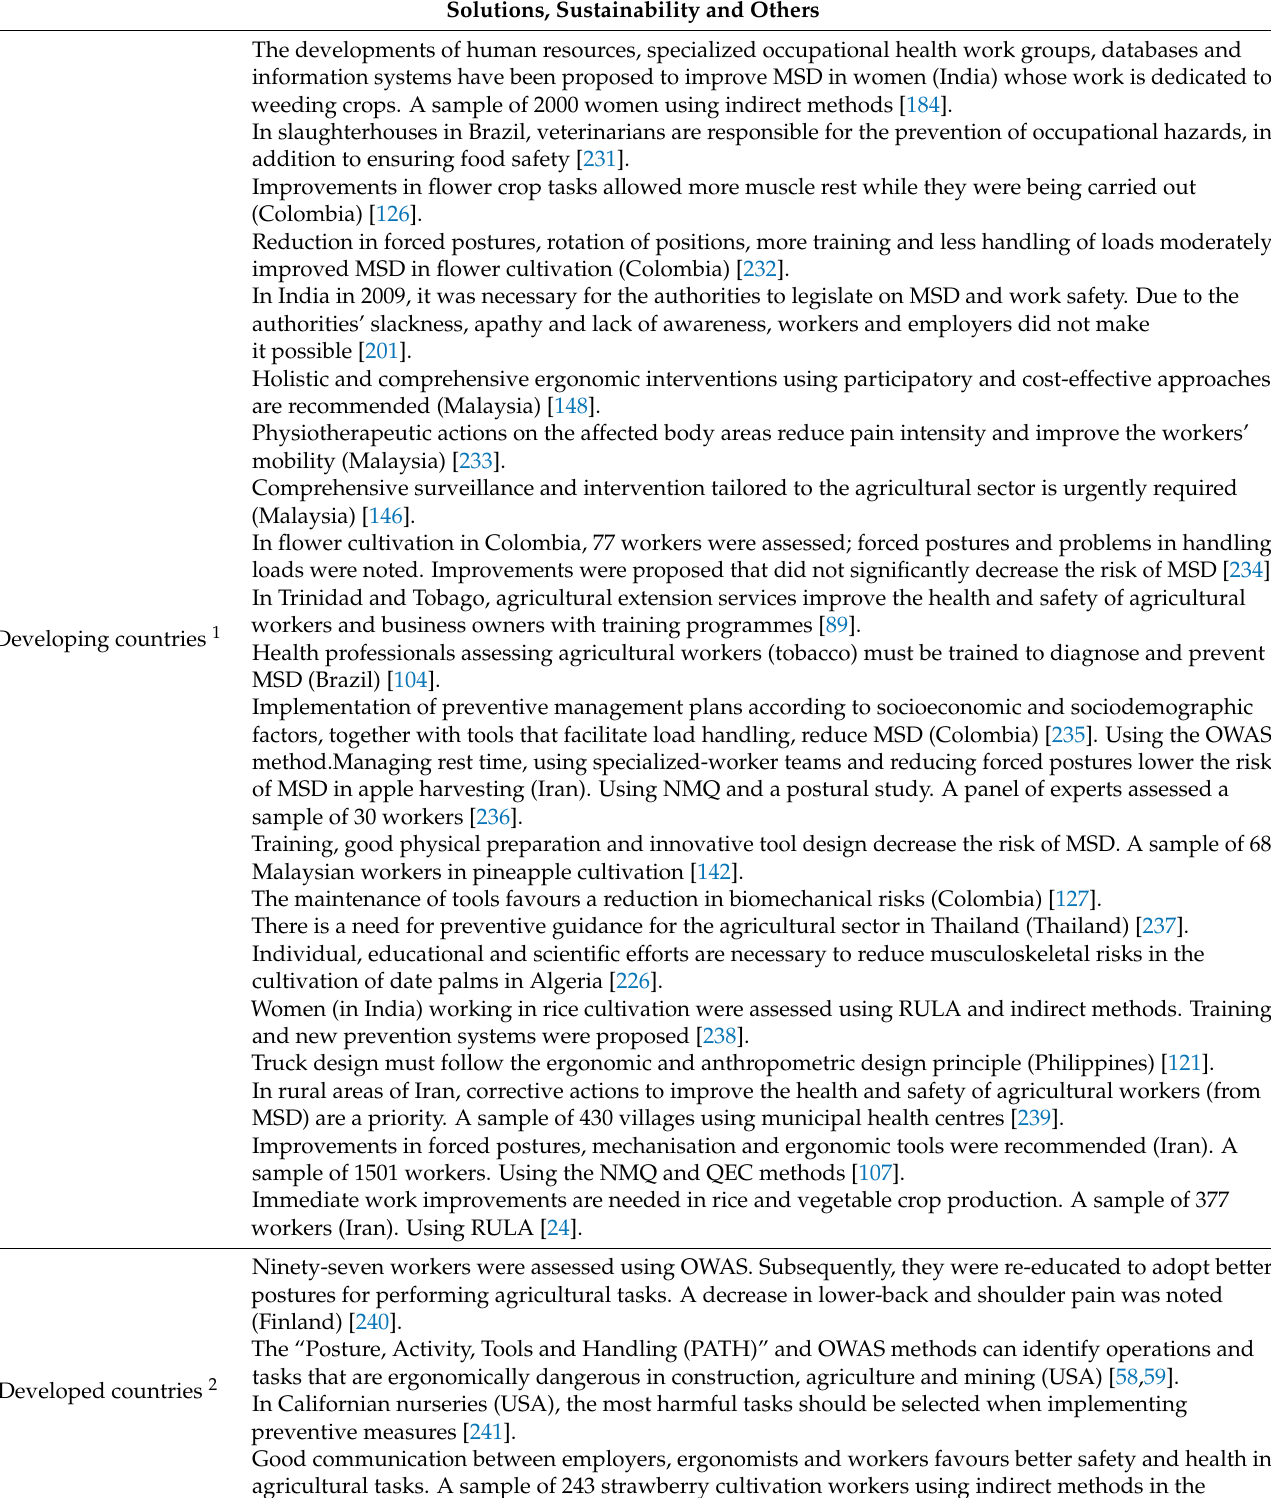
Table A11. MSD research in agriculture (1995–2020). Category: Solutions, sustainability and others. Solutions, Sustainability and